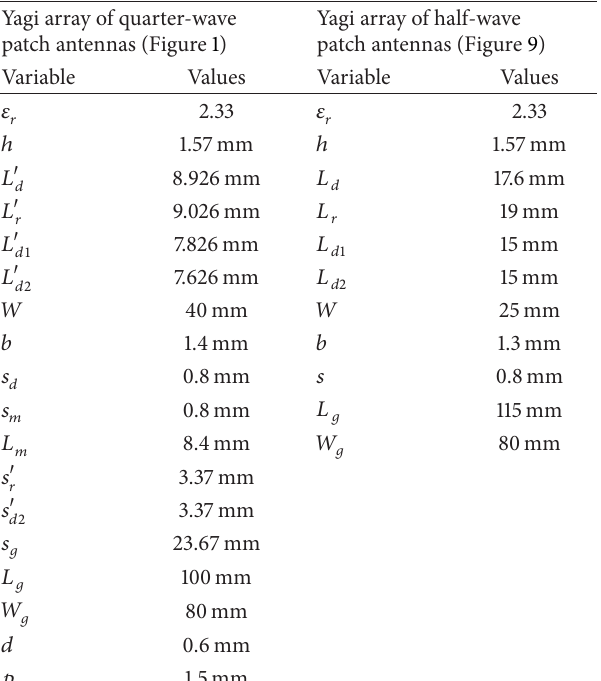
Table 1: Parameters for the Yagi